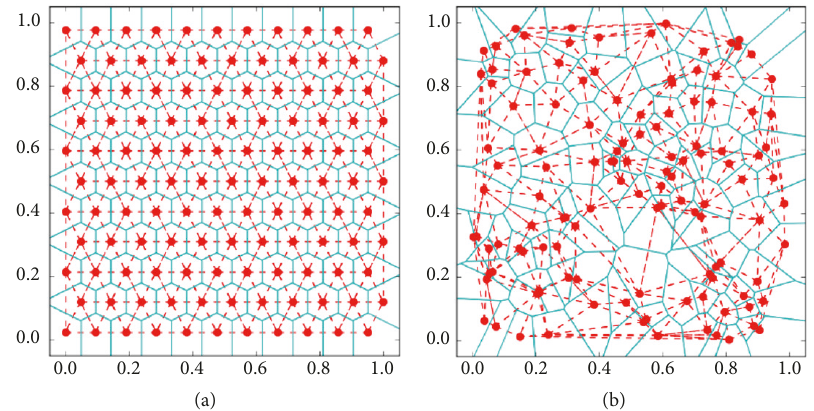
Figure 5: Examples of a uniformly distributed seed pattern (a) and a randomly distributed seed pattern (b) with both Voronoi tessellation and Delaunay triangulation.